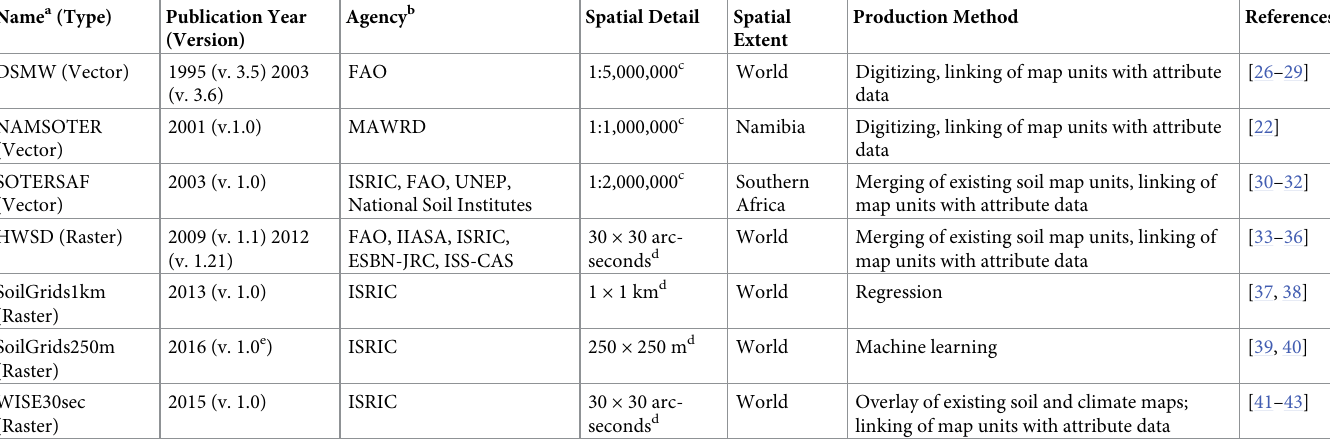
Table 1. Key characteristics of topsoil texture map data